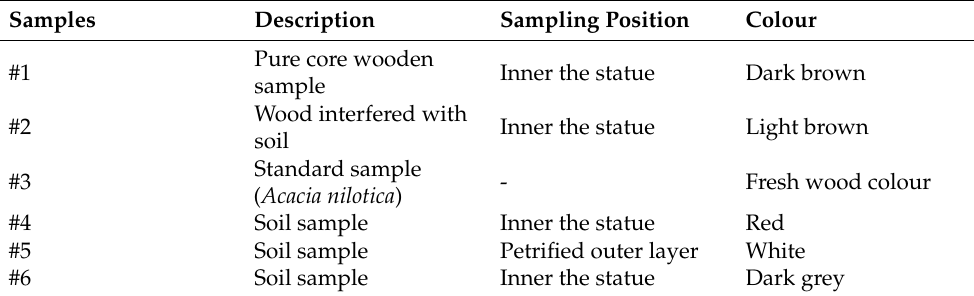
Figure 2. Sampling points (red arrows) of the archaeological wood samples #1 ( a ) and #2 ( b ).